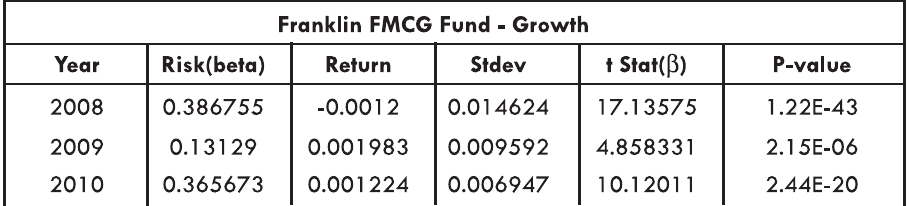
Table 6: Risk and Returns of Franklin FMCG Fund - Growth Scheme during the Study Period (2008 to 2010)